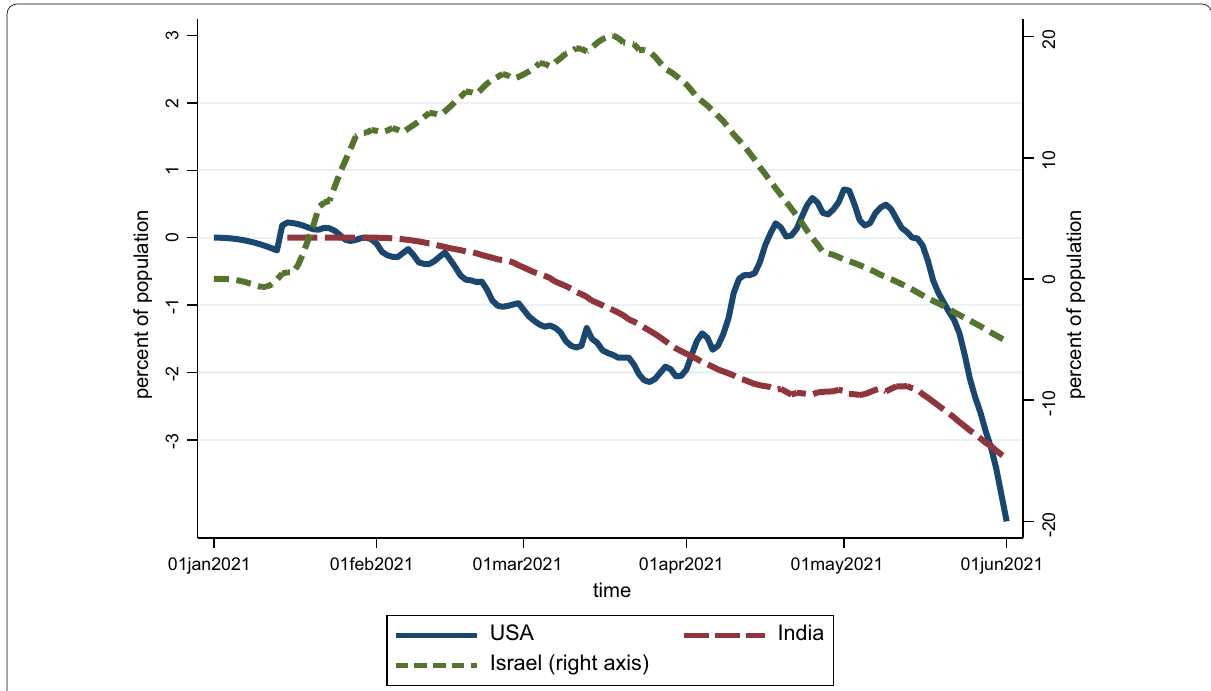
Fig. 2 Vaccine surprises, people fully vaccinated (percent of population). Source: Airfinity, Our World in Data, IMF staff calculations